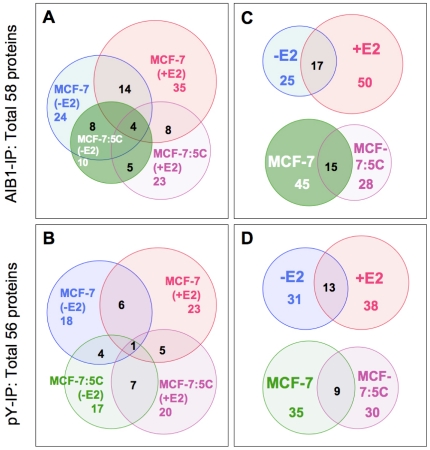
Summary of proteins identified under different conditions.Venn diagrams of proteins identified from anti-AIB1 (A,C) or anti-pY IP (B,D) experimental groups. (C,D) Proteins in combined AIB1-IP or pY-IP data sets. Individual proteins and subgroups are shown in Tables S1 & S2.